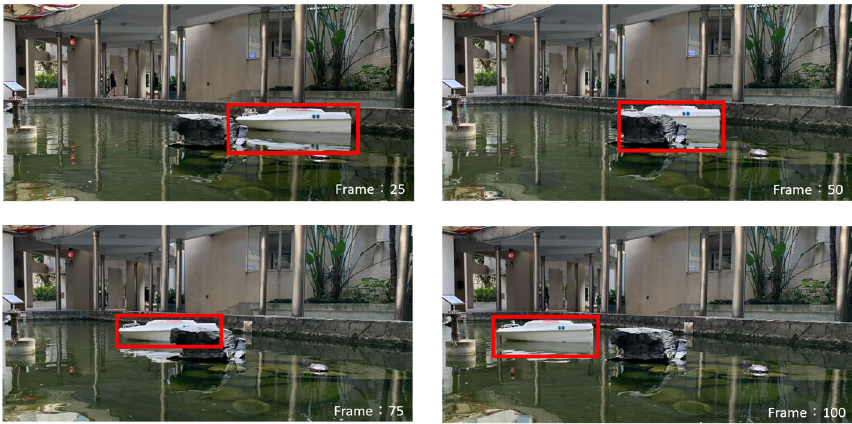
Figure 20. Target tracking of different scales in actual system navigation.